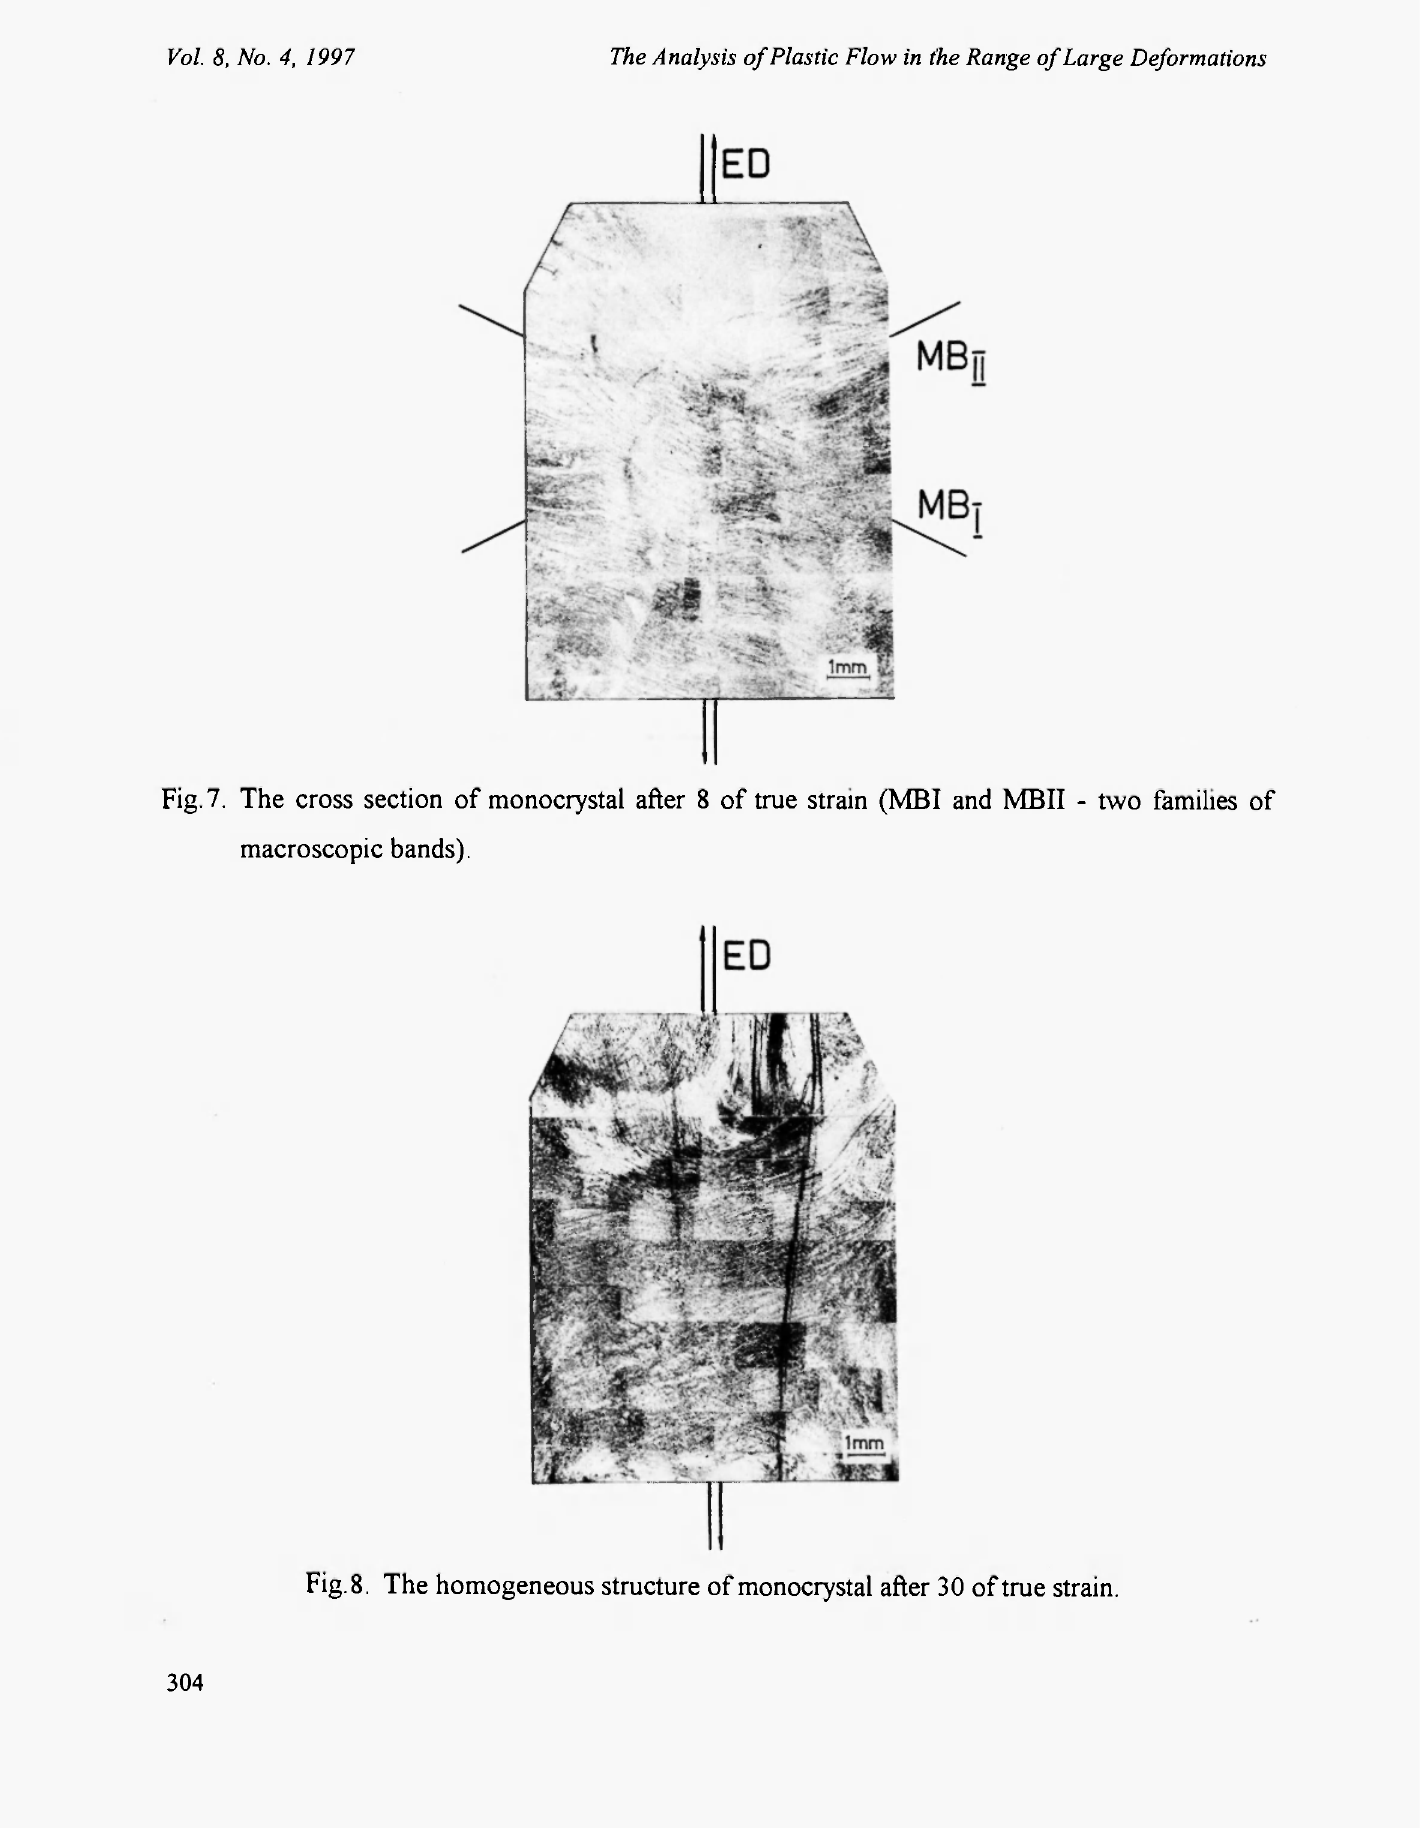
Fig.8. The homogeneous structure of monocrystal after 30 of true strain.